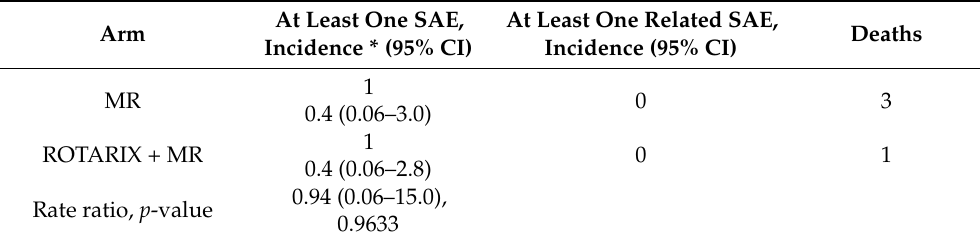
Table 4. Occurrence of serious adverse events in intervention (ROTARIX ® +MR) compared to control (MR)